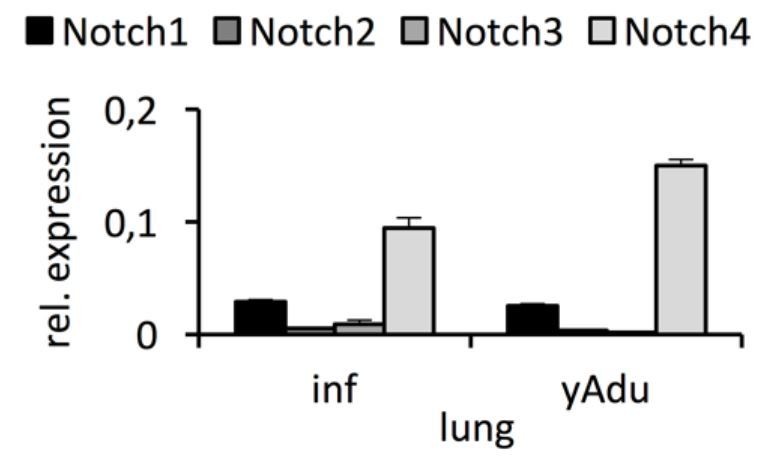
Expression of Notch receptors in lung EC.qPCR analysis was performed in independent biological samples. n≥3; mean ± SD..